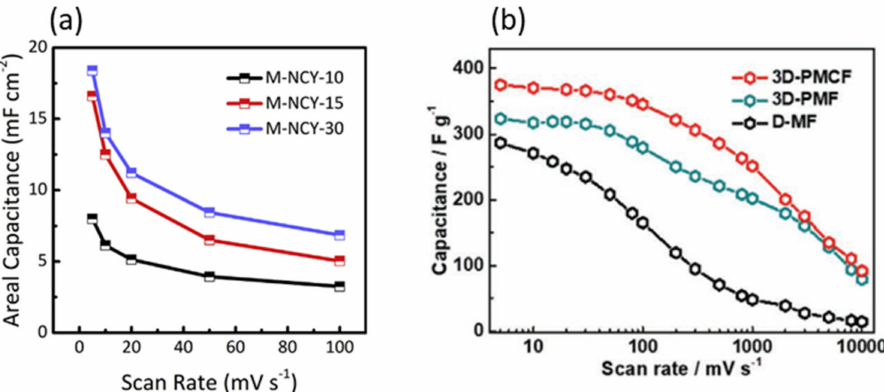
Figure 1. ( a ) Electrochemical performance of MXene-based nanofibers coated yarns (NCY) devices (M-NCY-10, M-NCY-15, and M-NCY-30 referred to the yarns obtained after 10, 15, and 30 min of electrospinning respectively)—variation in areal capacitances with scan rates. Reprinted (adapted) from Reference [48], copyright (2018) Elsevier. ( b ) Plots of gravimetric capacitance of 3D-PMCF and other counterparts against different scan rates. Reprinted (adapted) from Reference [49], copyright (2020) John Wiley and